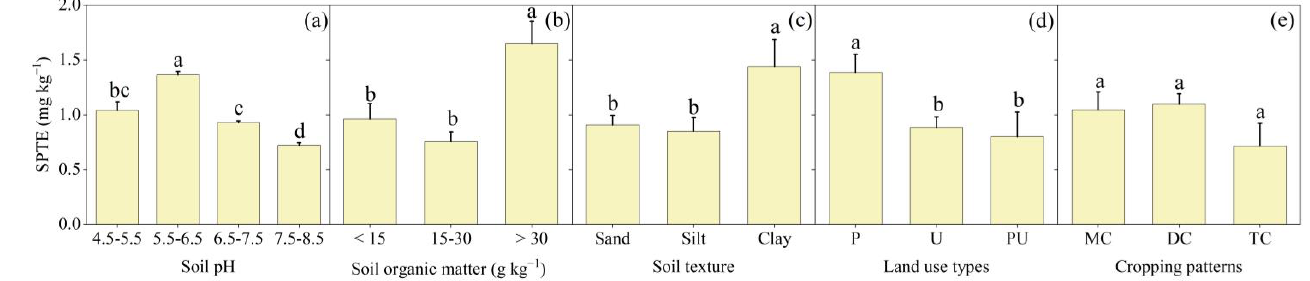
Figure 5. The differences of SPTE under various soil pH values ( a ), SOMs ( b ), soil textures ( c ), land use types ( d ), and cropping patterns ( e ). P, U, and P-U are paddy, upland, and paddy-upland, respectively. MC, DC, and TC are mono-cropping, double-cropping, and triple-cropping, respectively. Different lowercase letters indicate significant differences ( p < 0.05) under various soil pH, SOM, soil texture, land use types, and cropping patterns.